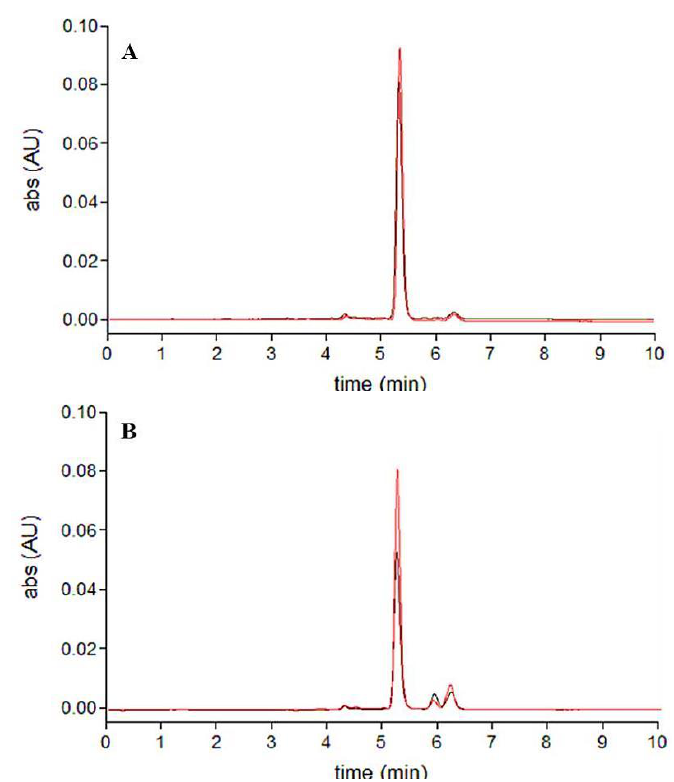
Figure 5. HPLC chromatograms (449 nm) of fucoxanthin standard solutions: ( A ) fucoxanthin standard solution-black, fucoxanthin standard solution with ascorbic acid-red; ( B ) after light